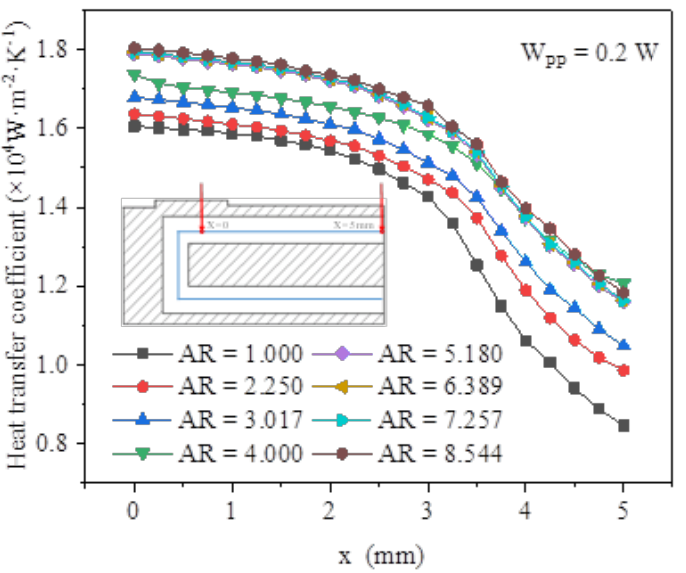
Figure 7. Heat transfer coefficient of rectangular microchannel upper channel with different aspect ratios.